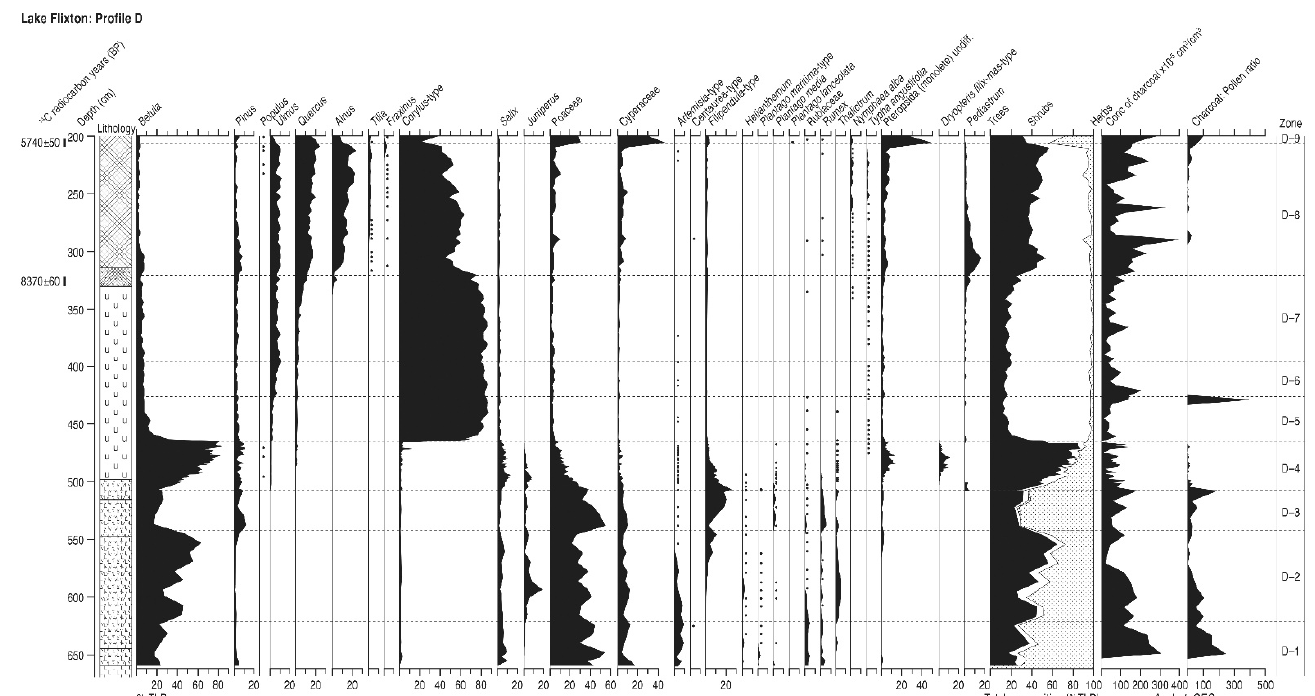
Figure 2. Percentage pollen diagram from Profile D. (Analysis GEC).